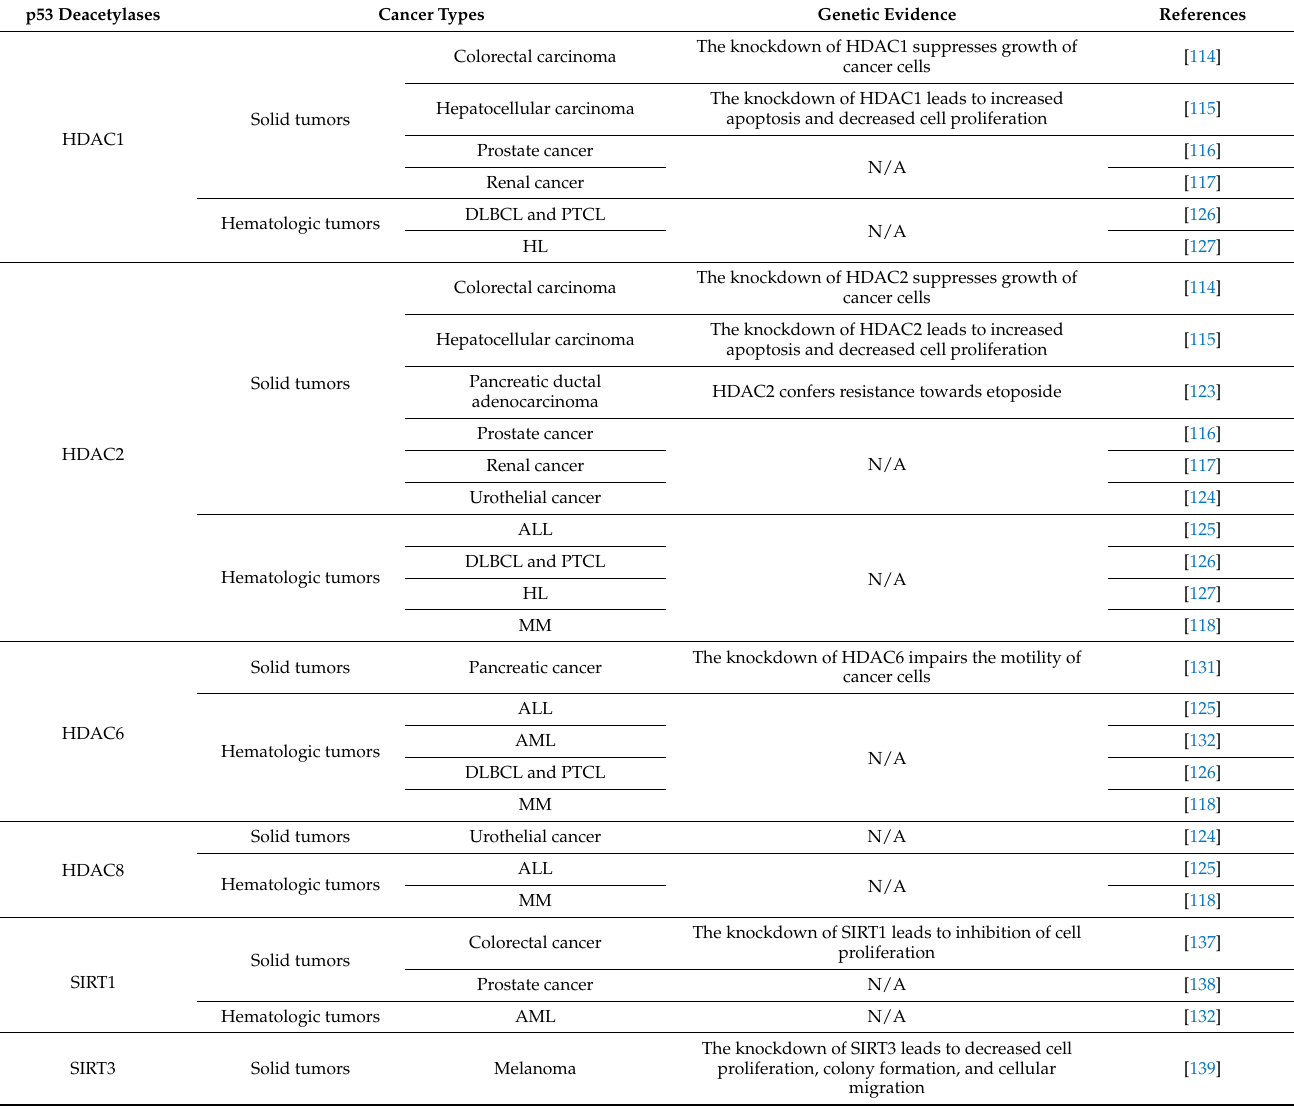
Table 2. List of cancer types with highly expressed p53